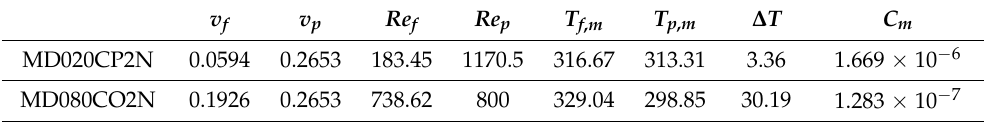
Table 5. Results of the transmembrane flux for different membrane thicknesses.